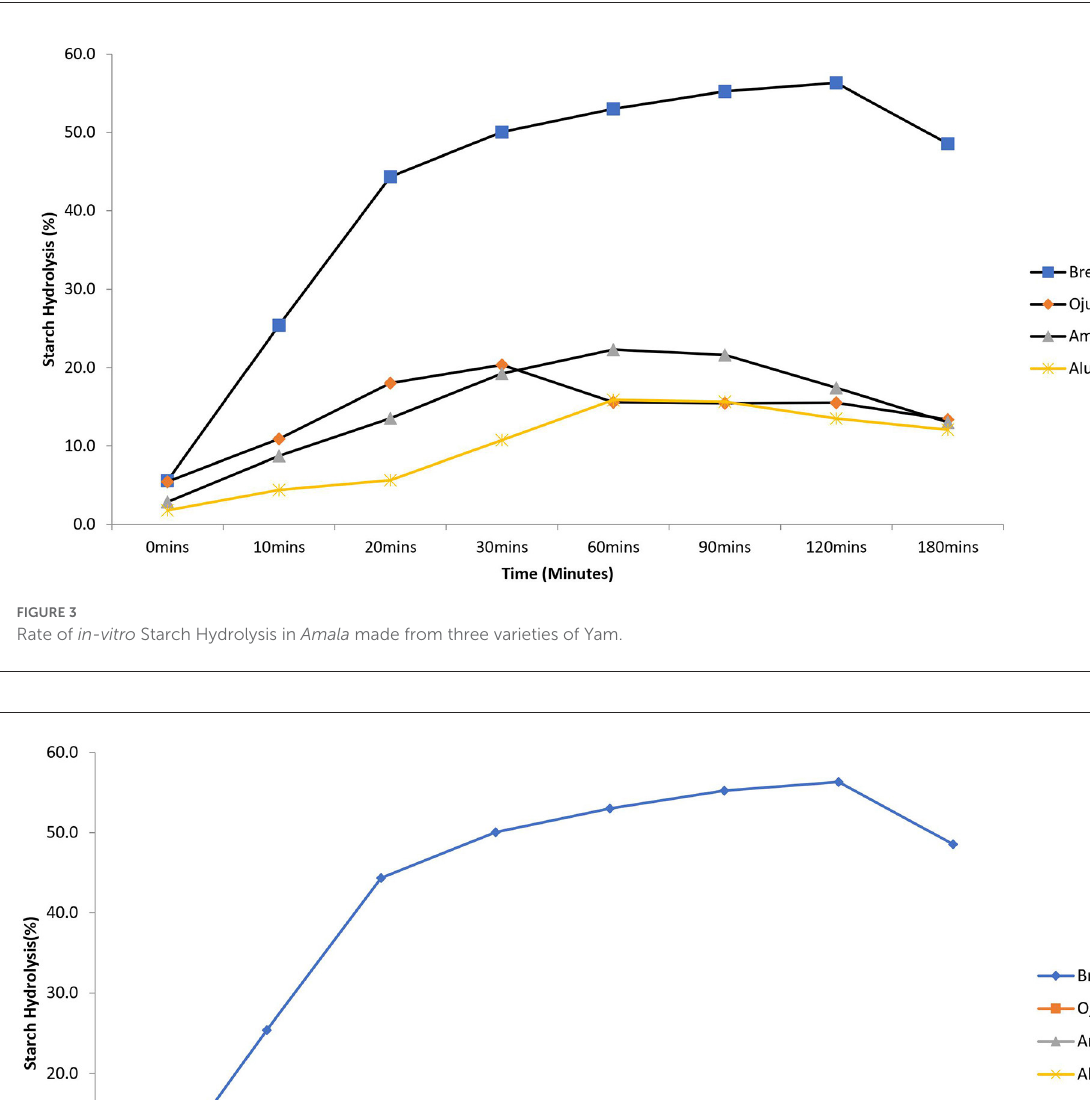
eGI values across both varieties and products, respectively (Table 3). This distinction in each variety and product were more pronounced when the products were subjected to in vitro analysis than results gotten from the in vivo test.